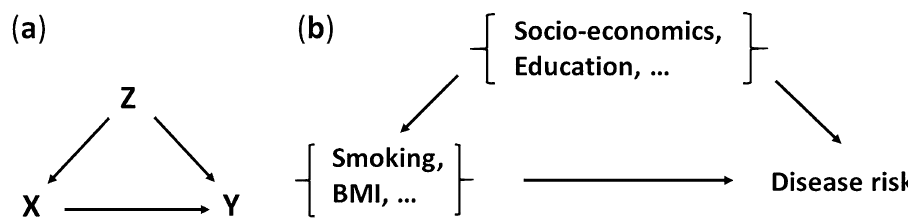
Figure 1. Consider the influence of one or more exposures X , on diseases Y , with confounding variables Z that satisfy the “backdoor criteria” 1,7 ( a ). For example, X might include BMI, alcohol, and smoking, with confounders Z of socio-economic status and education ( b